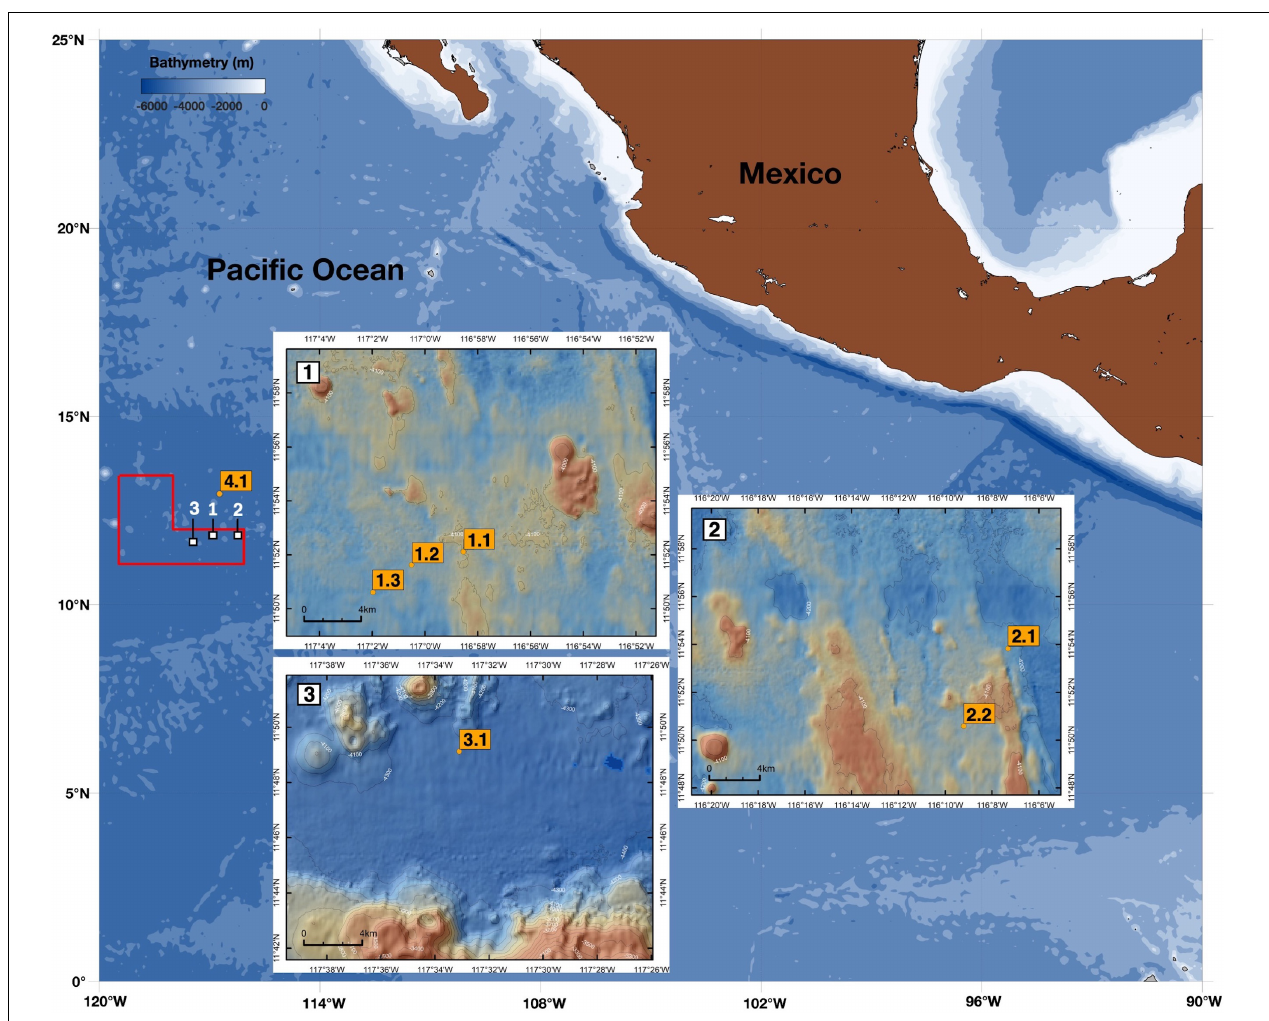
FIGURE 1 | Map showing camera deployment stations in relation to the bathymetry of the study area. The three study sites (WA 1–3) are located within the eastern German license area for nodule exploration (red polygon), in the north-eastern Pacific Ocean. Camera-profiling stations are indicated by yellow boxes. Bathymetry of the WA area is based on EM 120 measurements (Wiedicke-Hombach and Shipboard Scientific Party, 2009). Contours are 100 m; resolution of each data point is 120 m by 120 m.